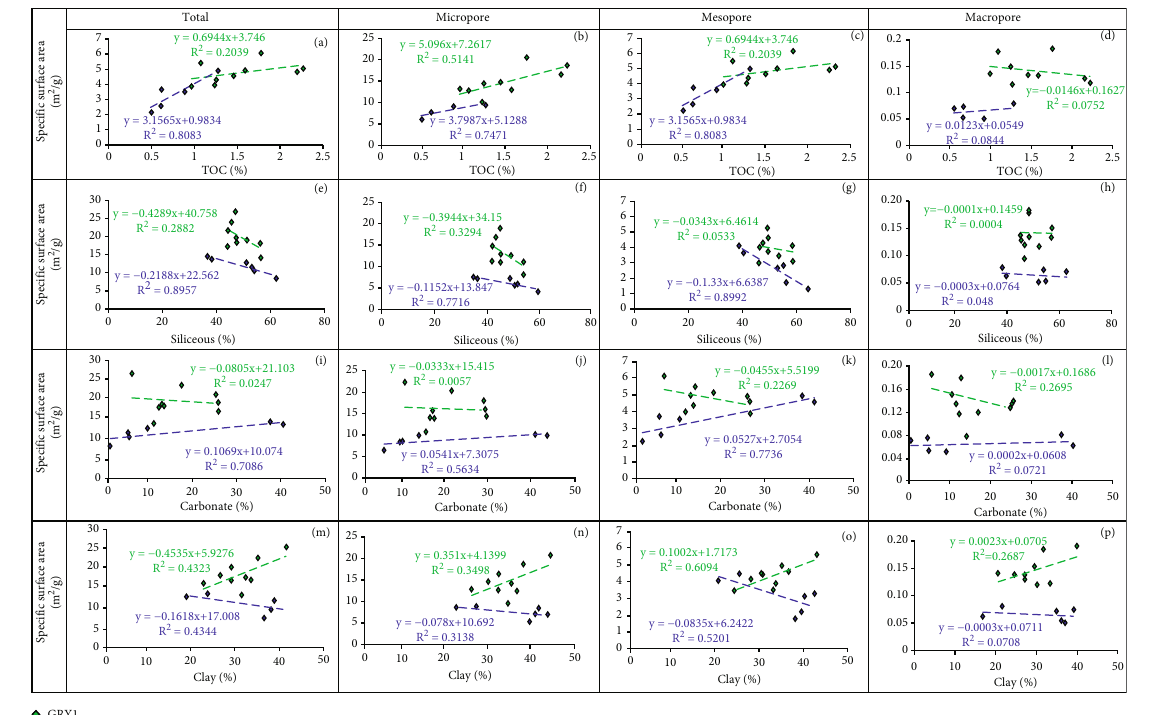
Figure 11: Correlation between shale material composition and speci fi c surface